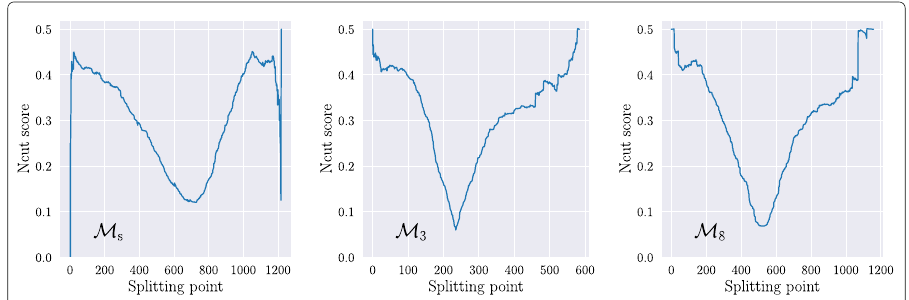
Fig. 14 Sweep profiles for different motifs on the US-P OLITICAL -B LOGS network. M s corresponds to using the symmetrized adjacency matrix